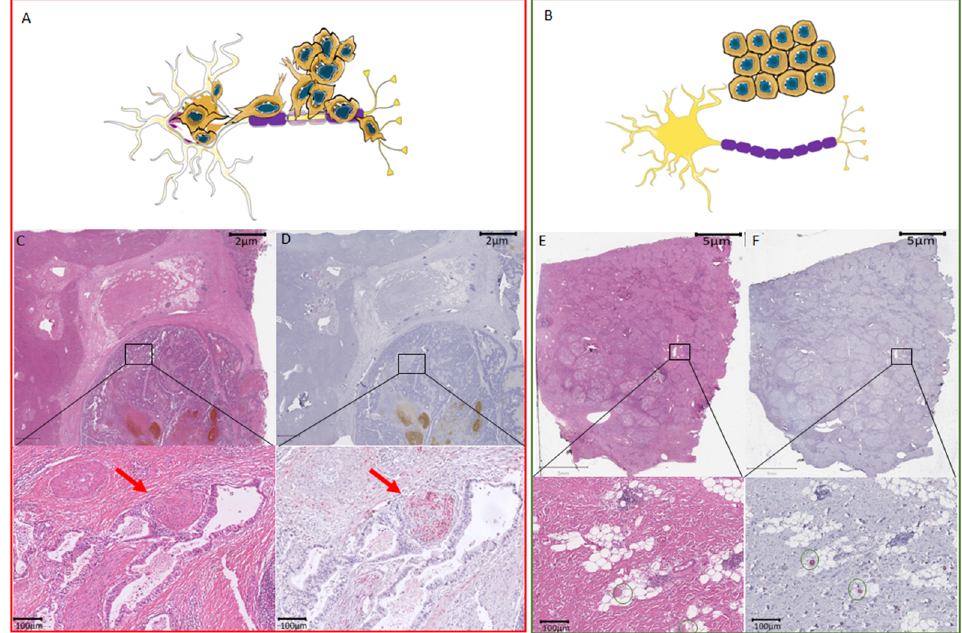
Figure 1. Difference between perineural invasion and nerve fiber density with respect to hepatocellu- lar carcinoma. ( A ) Schematic overview of tissue with cancers cells invading the nerve. ( B ) Schematic overview of tissue with NFs in the TME. ( C ) Routine HE staining showing of HCC. The black box illustrates the zoomed-in area shown underneath with perineural invasion by cancer cells invading a large nerve trunk (red arrow). ( D ) Consecutive slide used for immunohistochemistry with the neu- ronal marker PGP9.5. The black box illustrates the zoomed-in area shown underneath with perineural invasion by cancer cells invading a large nerve trunk (red arrow). The nerve trunk is illustrated in red. ( E ) Routine HE staining showing of HCC. Routine HE staining with the black box indicates the localization of the small nerve fibers that are not visible on the HE staining. Green circles in the zoomed-in image mark the regions where the small nerve fibers are found by immunohistochemistry. ( F ) Consecutive slide used for immunohistochemistry with the neuronal marker PGP9.5. The black box illustrates the zoomed-in area shown underneath with the presence of small nerve fibers without cancer invasion. These small nerve fibers are illustrated in red and marked by green circles.